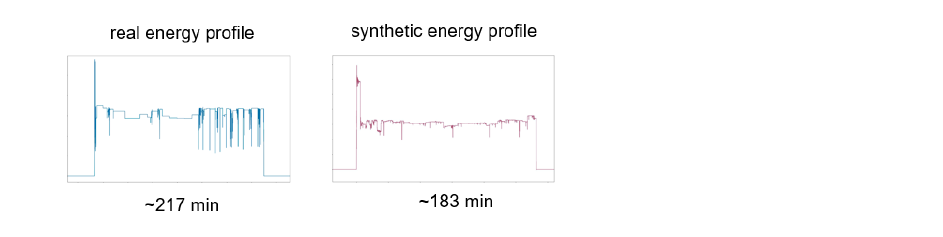
Figure 6. Comparison of a TV’s real ( left ) and synthetic (using XGBoost, right ) energy consumption.